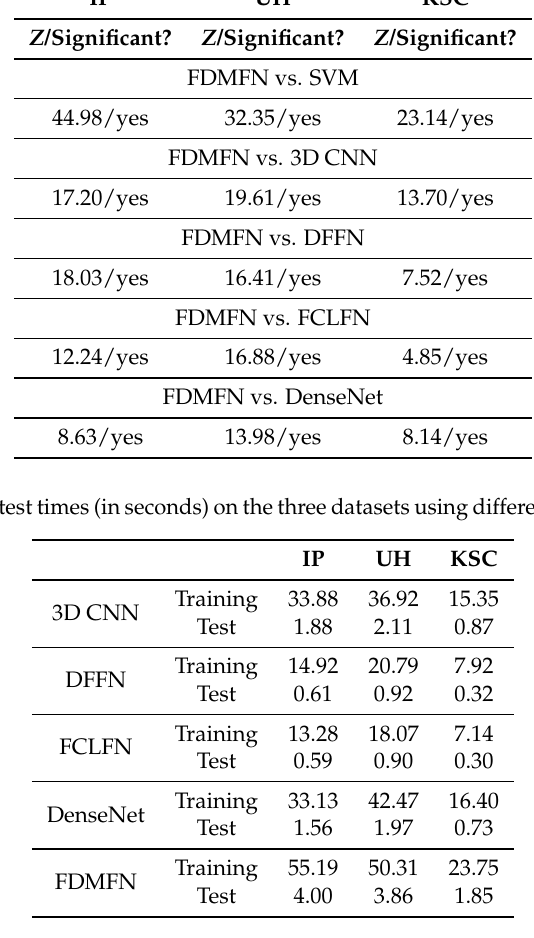
Table 11. Numbers of trainable parameters in different deep neural